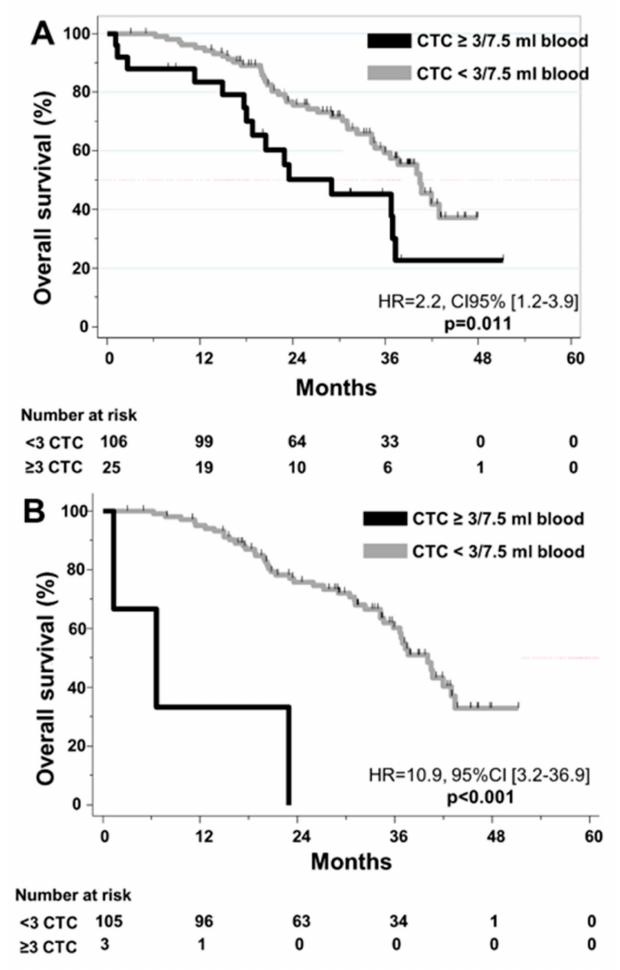
Figure 3. Kaplan–Meier curves for Overall Survival according to CTC detection ( A ) at baseline. ( B ) at 4